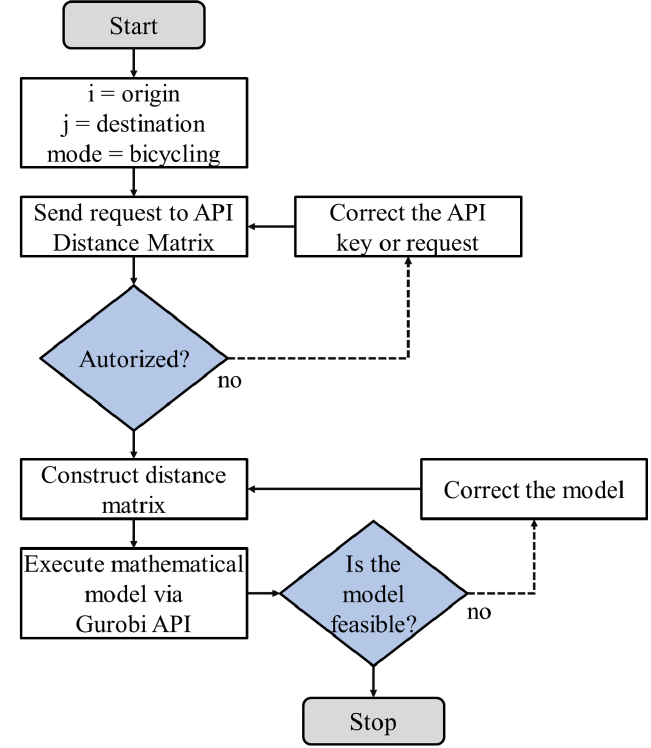
Figure 5. Distance-time acquisition